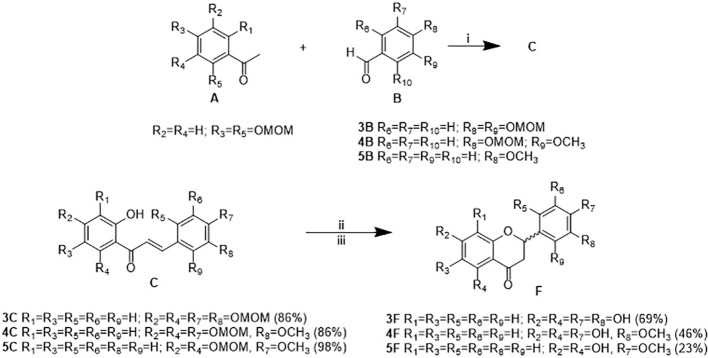
Preparation of flavanones (3, 4, and 5) via Claisen-Schmidt condensation in alkaline medium of acetophenone A and benzaldehydes B (i: KOH/MeOH/H2O) to produce chalcones C, cyclization of chalcones C under mild alkaline conditions (ii: NaOAc, EtOH-H2O, reflux), and acid hydrolysis (iii: HCl 1N, MeOH, reflux) to obtain flavanones F. Reaction yields are shown in brackets.